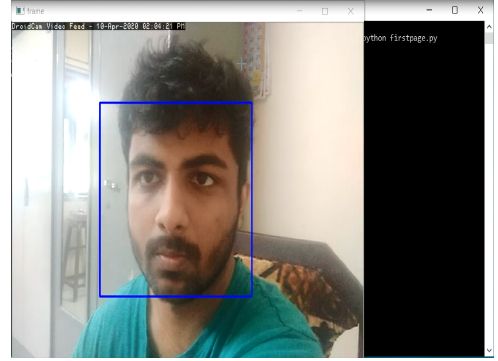
Figure 4. First detection of image using haar cascade